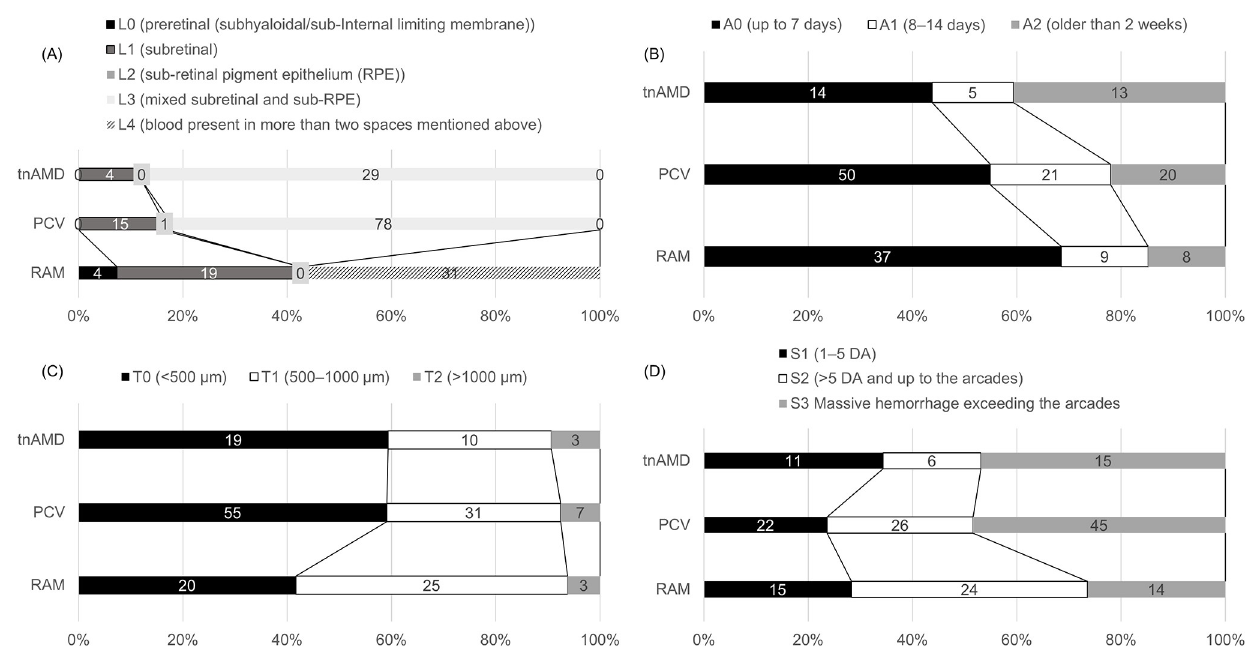
Fig 1. Classification of SMH in cases with tnAMD, PCV, and RAM by FLATCAPS classification. (A) Layers involving hemorrhage. (B) Duration of symptoms. (C) Thickness of hemorrhage. (D) Extent of hemorrhage. tnAMD: typical neovascular age-related macular degeneration. PCV: polypoidal choroidal vasculopathy RAM: retinal arterial microaneurysm, RPE: retinal pigment epithelium, DA: disc area.